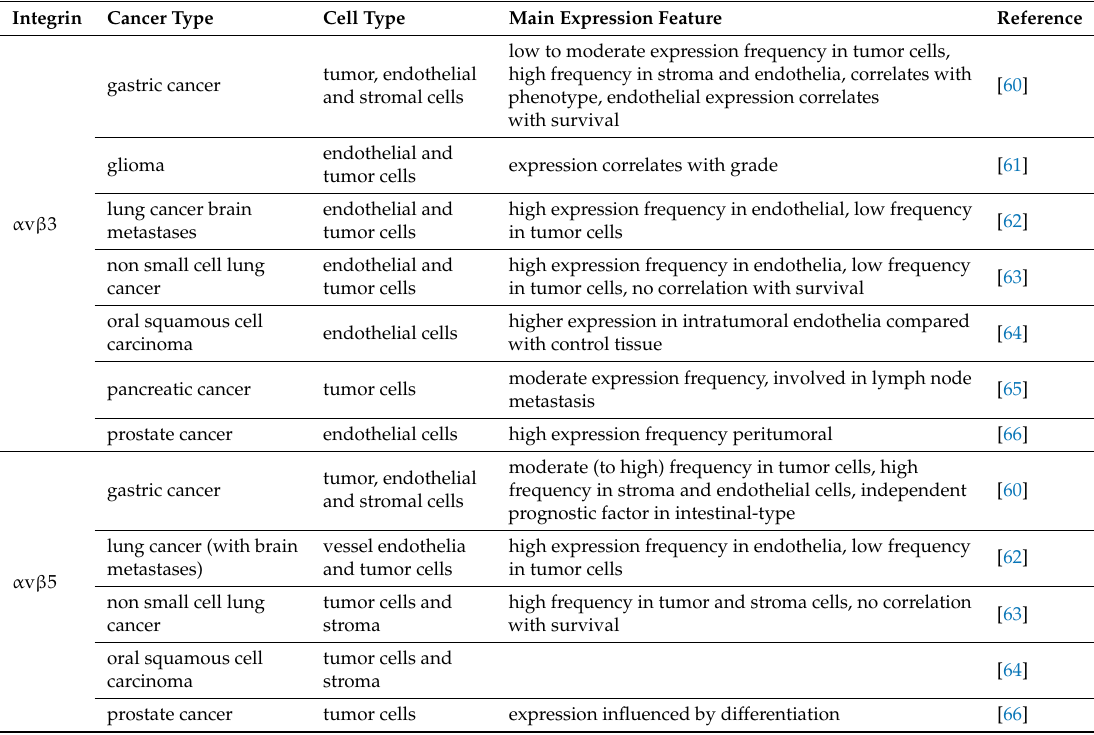
Table 1. Overview table of RGD-binding integrins expressed in various human cancers at the tissue level with respect to the expressing cell type and, if available, the prognostic